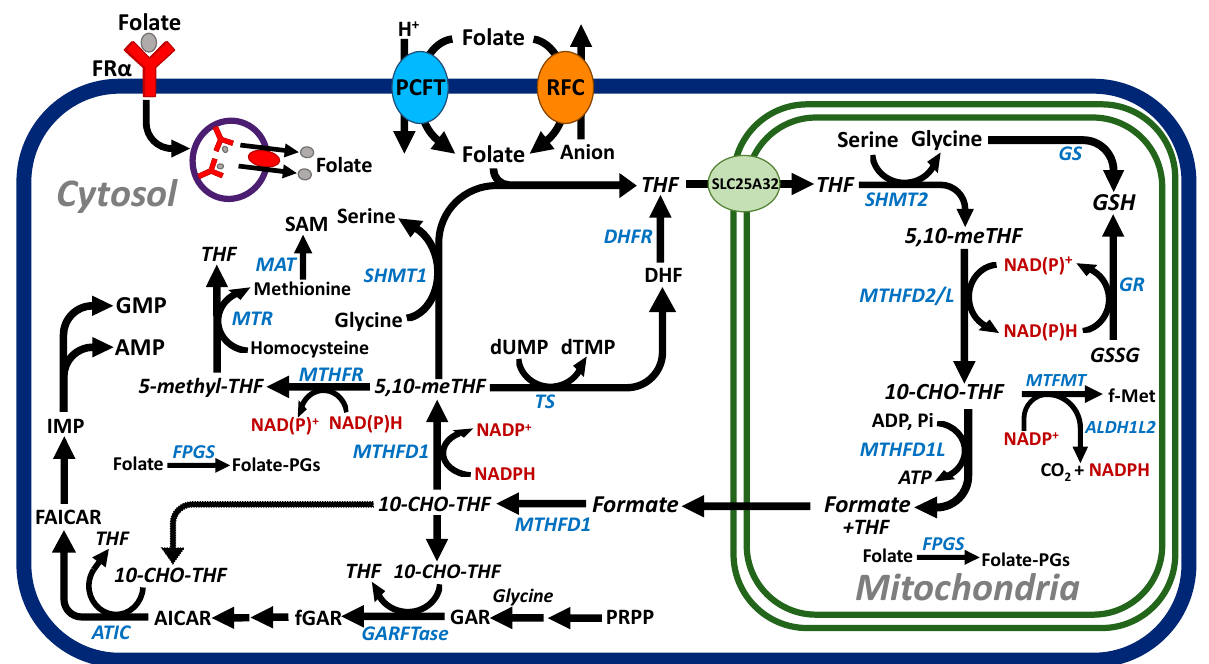
Figure 1. Folate transport and C1 metabolism. A schematic is shown depicting cellular uptake by facilitative transport via RFC or PCFT or by endocytosis via FR α . Intracellular folates are metabolized to polyglutamate conjugates. Folate “monoglutamates” are transported into the mitochondria by SLC25A32. In the mitochondria, serine is catabolized by sequential SHMT2, MTHFD2/L, and MTHFD1L through which the C1 moiety from serine C3 is incorporated into formate, thus providing C1 units for cellular biosynthesis in the cytosol. Abbreviations are as follows: 10-CHO-THF, 10- formyl tetrahydrofolate; 5,10-me-THF, 5,10-methylene tetrahydrofolate; AICAR, 5-aminoimidazole-4-carboxamide; ALDH1L2, aldehyde dehydrogenase 1 family member L2; ATIC, 5-aminoimidazole-4-carboxamide ribonucleotide formyltransferase; DHF, dihydrofolate; DHFR, dihydrofolate reductase; FAICAR, formyl 5-aminoimidazole-4-carboxamide ribonucleotide; fGAR, formyl glycinamide ribonucleotide; FPGS, folylpoly- γ -glutamate synthetase; GAR, glycinamide ribonucleotide; GARFTase, glycinamide ribonucleotide formyltransferase; GR, glutathione reductase; GS, glutathione synthetase; GSH, glutathione; MTFMT, methionyl tRNA formyltransferase; MTHFD1, methylenetetrahydrofolate dehydrogenase 1; MTHFD2(L), methylene tetrahydrofolate dehydrogenase 2(-like); MTHFR, methylenetetrahydrofolate reductase; MTR, methionine synthase; PCFT, proton-coupled folate transporter; PGs, polyglutamates; PRPP, phosphoribosyl pyrophosphate; RFC, reduced folate carrier; SAM, S-adenosylmethionine; SHMT1/2, serine hydroxymethyltransferase 1/2; THF, tetrahydrofolate; and TS, thymidylate synthase.